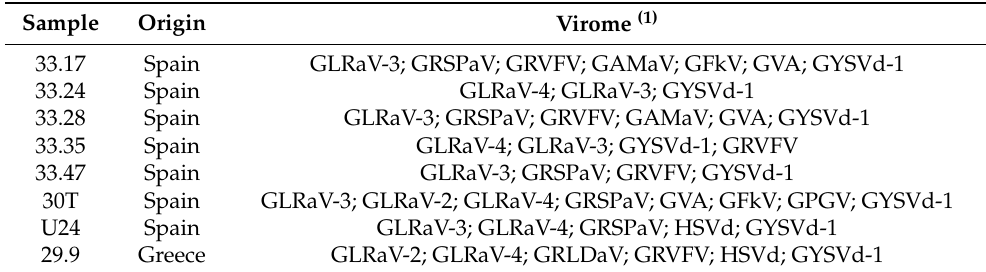
Table 3. Virome analysis of GLRaV-1 free grapevine samples determined by